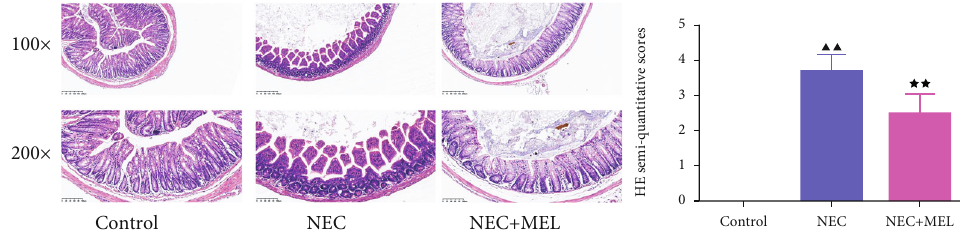
Figure 2: MEL improved the histopathological injury in NEC mice. The e ff ect of MEL on the histopathological injury in NEC mice was examined by H&E staining. The histopathological score was estimated by two independent pathologists who were unaware of the study conditions based on the histopathological scoring system. ▲▲ P < 0 : 01 vs. control; ★★ P < 0 : 01 vs. NEC.